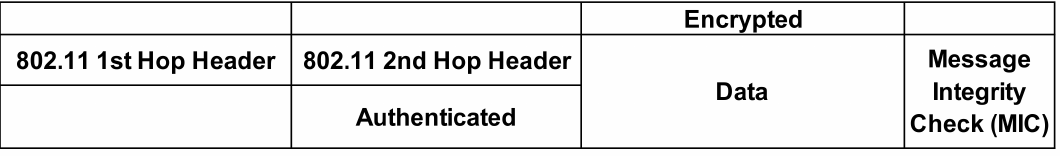
Figure 8. Scheme for two headers.